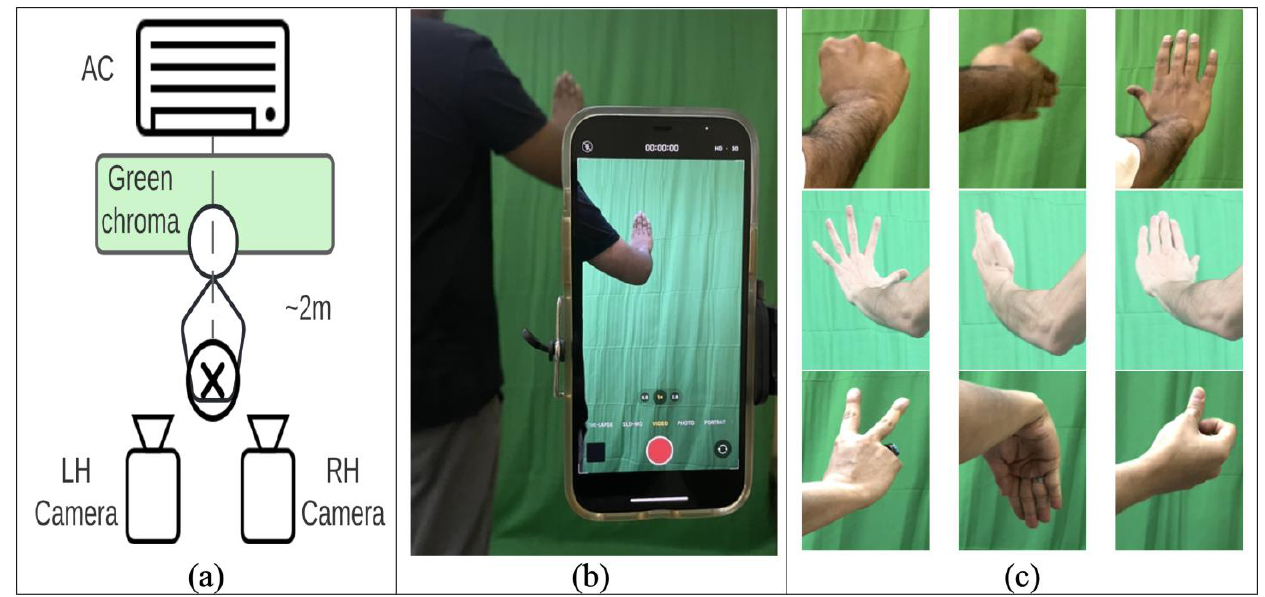
Figure 1. ( a ) Sketch of experiment environment; ( b ) a camera recording a participant’s right hand; ( c ) examples of participants’ gestures.